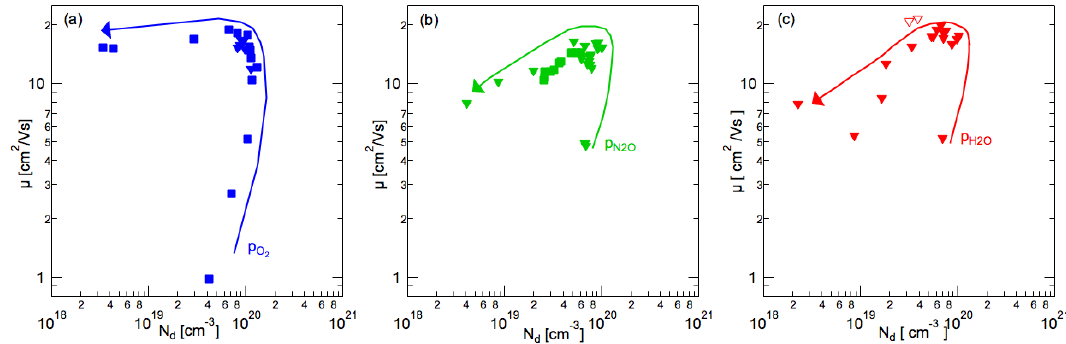
Figure 5. Dependence of the Hall electron mobility on the carrier concentration for SnO 2 :Ta films sputtered with different reactive gases: ( a ) O 2 (blue) ( b ) N 2 O (green), and ( c ) H 2 O (red). The lines with arrows in the figures indicate the increasing reactive gas partial pressure. Deposition parameters: 15 W DC , 25 W DC , 100 W RF , 30 W RF , p total = 0.5 Pa, RT.